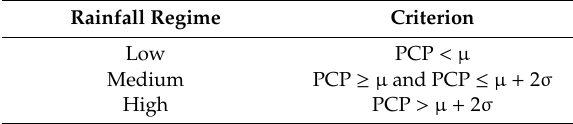
Table 2. Partition of overall precipitation time series into low, medium, and high precipitation time series (PCP is precipitation, µ is mean of rainfall, and σ is the standard deviation of